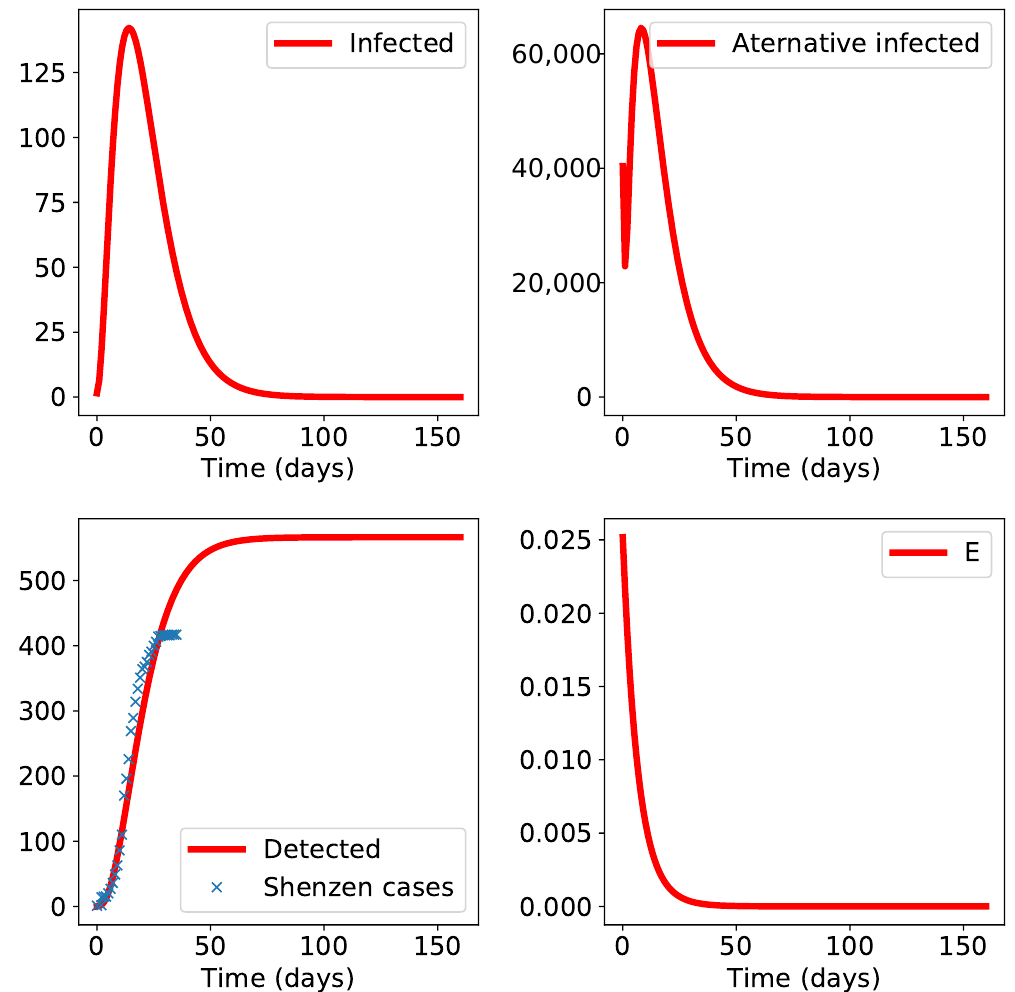
Figure 5. Results of the SLIADRE model for Shenzen. The initial time t 0 is set to January 19th. The apparent misfit at the end of the empirical data time range is due to the fact that the database was not updated for several days (thus the cumulative numbers will show a constant trend, in contradiction with the real epidemic behavior). The class “E” is small and decreasing which indicates negligible environmental